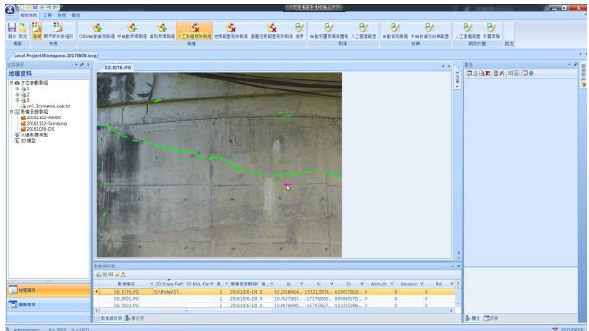
Figure 22. The designed GUI for bridge inspection.